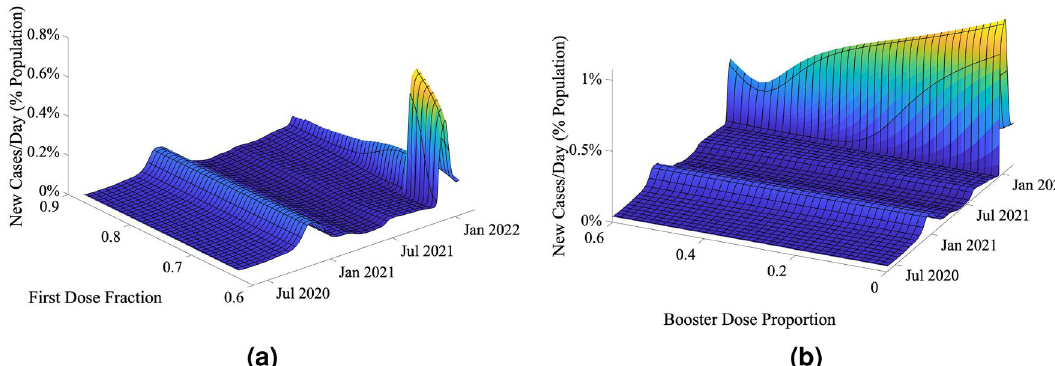
Figure 6. Evaluation of vaccine allocation strategies, assuming that only a set number of the first, second, and booster vaccine doses combined can be administered ( α 1, prop + α 2, prop + α B , prop = 1 ). Sensitivity of pandemic trajectories with respect to ( a ) a fixed number of doses for the booster vaccines (60% of the total doses being administered), and the relative proportions of first and second vaccine doses being varied, and ( b ) a variable number of booster doses, where changes in the amount of booster doses were accommodated by changing the proportions of the first and second doses